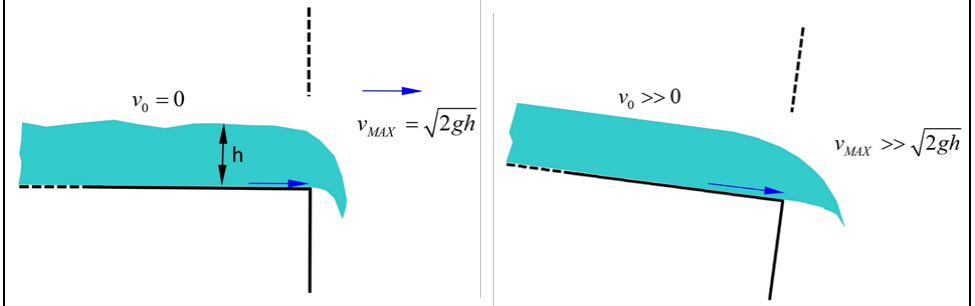
Figure 7. The flow on the horizontal and inclined vehicle decks at the damage opening.